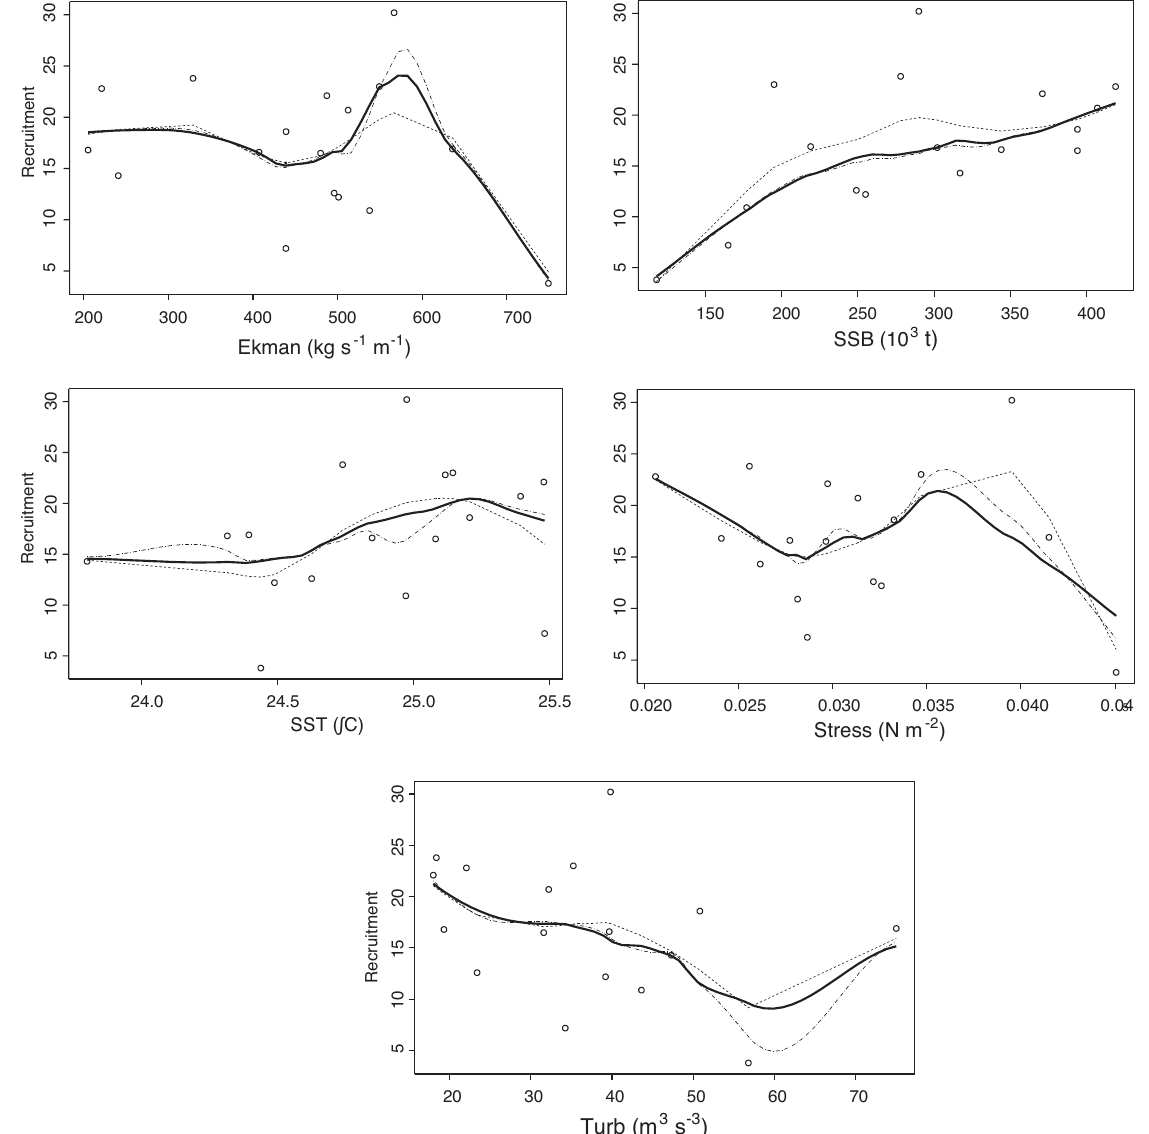
F IG . 5. – Recruitment as a function of possible predictor variables – spawning stock biomass (SSB), Ekman transport (Ekman), turbulence index (Turb), wind stress (Stress) and sea surface temperature (SST). A trend line was fitted with smoothers (lowess with span = 0.50 – dot- and-dashed line; lowess with span = 0.55 – solid line; smooth spline – dashed line). The points are observed values. Recruitment is given in billions of